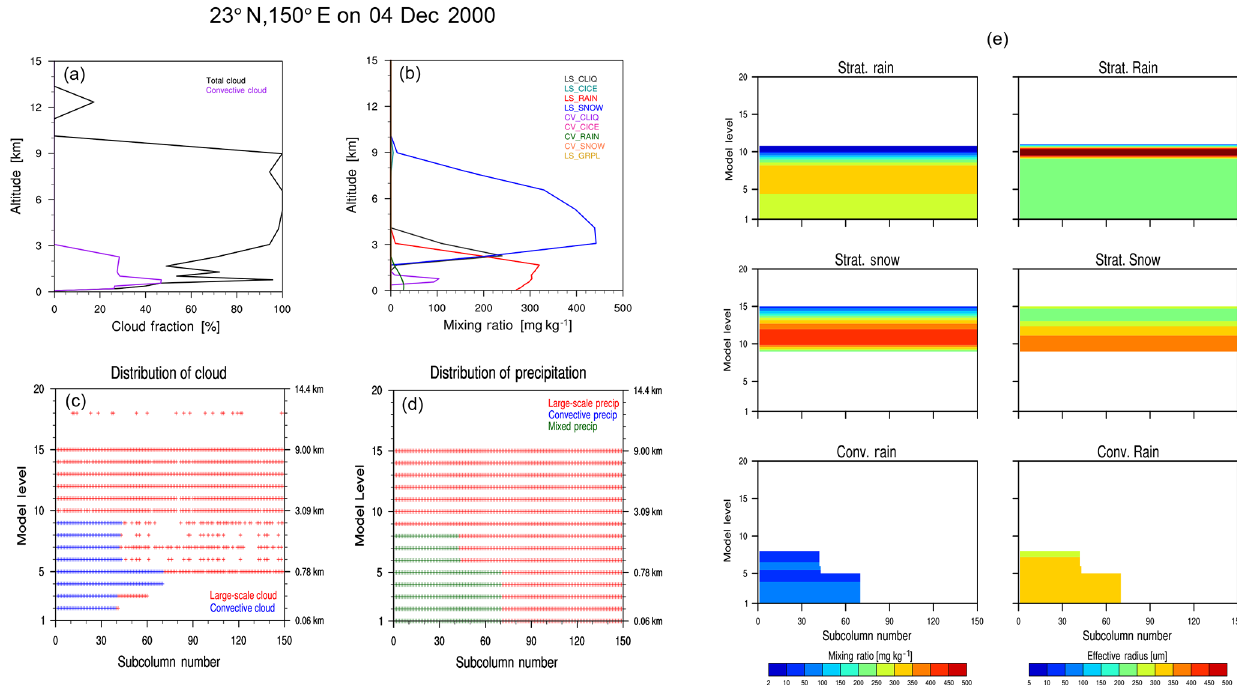
Figure 2. At the single-grid 23 ◦ N and 150 ◦ E on 4 December 2010 in the CAM5-Base simulation (Song et al., 2017): (a) the grid-mean total (stratiform plus convective) and convective cloud fraction. (b) The grid-mean mixing ratios of cloud and precipitation hydromete- ors (LS_CLIQ: large-scale (i.e., stratiform) cloud water; LS_CICE: large-scale cloud ice; LS_RAIN: large-scale rain; LS_SNOW: large- scale snow; LS_GRPL: large-scale graupel; CV_CLIQ: convective cloud water; CV_CICE: convective cloud ice; CV_RAIN: convective rain; CV_SNOW: convective snow). (c) The distribution of large-scale (red plus signs for frac_out = 1) and convective (blue plus signs for frac_out = 2) cloud among the sub-columns generated by the SCOPS scheme (i.e., frac_out from scops.f). (d) The distribution of large-scale (red plus signs for prec_frac = 1), convective (blue plus signs for prec_frac = 2), and mixed (green plus signs for prec_frac = 3) precipitation among the sub-columns generated by the SCOPS-PREC scheme (i.e., prec_frac from prec_scops.f). (e) The mixing ratio (left panels) and effective radius (right panels) of three precipitation hydrometeor types among the